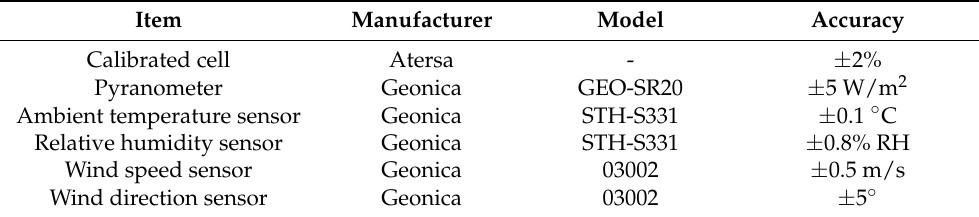
Table 3. Measuring instruments details.